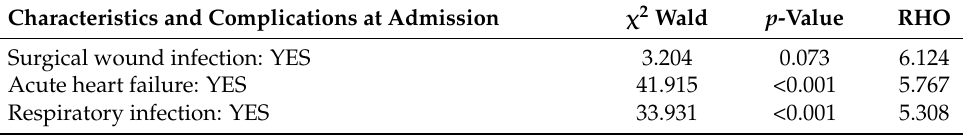
Table 6. Results of binary logistic regression to estimate the relationship between mortality at the sixth month and characteristics and complications at